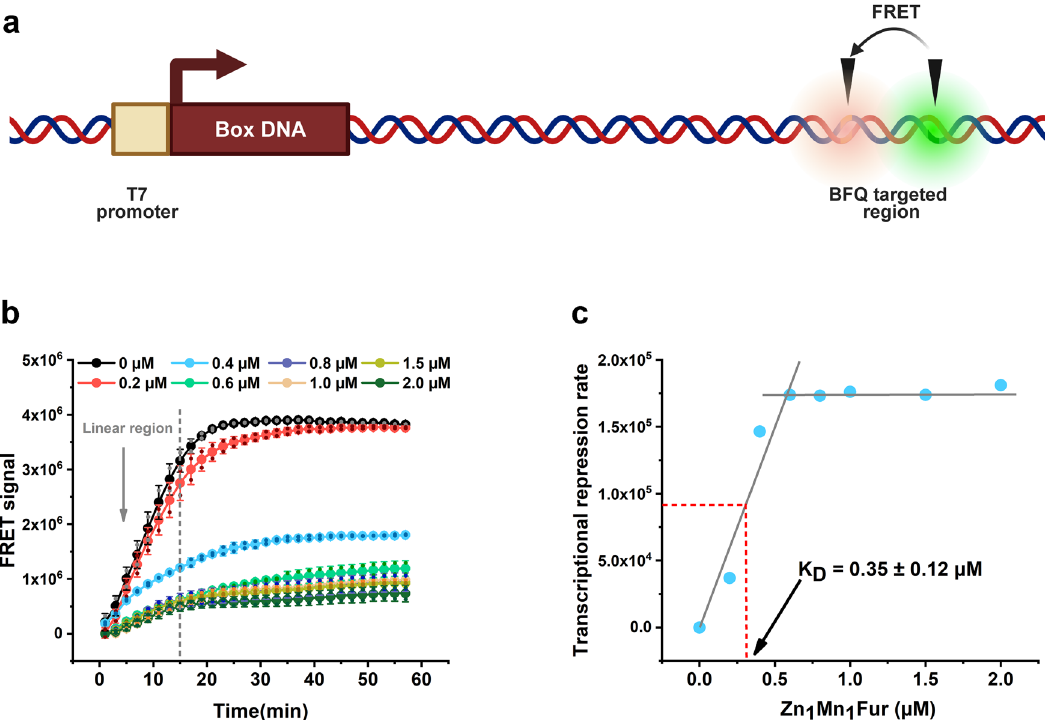
Fig. 6 Using RT-IVT assays to detect the DNA-binding coef fi cient of transcriptional inhibitor. a Principles for DNA template design. Figure was created with Biorender (www.bioender.com). b The relative quantitative results (signal corrected) for the DNA template Fur after Zn 1 Mn 1 Fur was added. The reaction con fi guration and detection conditions are identical to those shown in Fig. 3a, except 30 nM DNA template Fur replaced DNA template 1, and 0 ‒ 2 µ M Zn 1 Mn 1 Fur was added. c The K D value for Fur binding to the Fur box DNA. The initial transcription velocity for the 0 ‒ 2 µ M Zn 1 Mn 1 Fur added groups were measured by fi tting the slope of the 1 ‒ 15 min reaction region of Fig. 6b. The transcriptional repression rates were calculated using the initial transcription velocity of 0 µ M Zn 1 Mn 1 Fur group subtracted by the corresponding groups. The Zn 1 Mn 1 Fur concentration corresponds to half of the maximum transcriptional inhibition rates and represents the K D value of Zn 1 Mn 1 Fur with the Fur box DNA. The values represent the mean ± standard deviation of n = 2